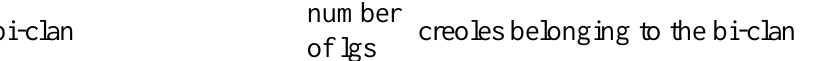
Table 2. 20 creole